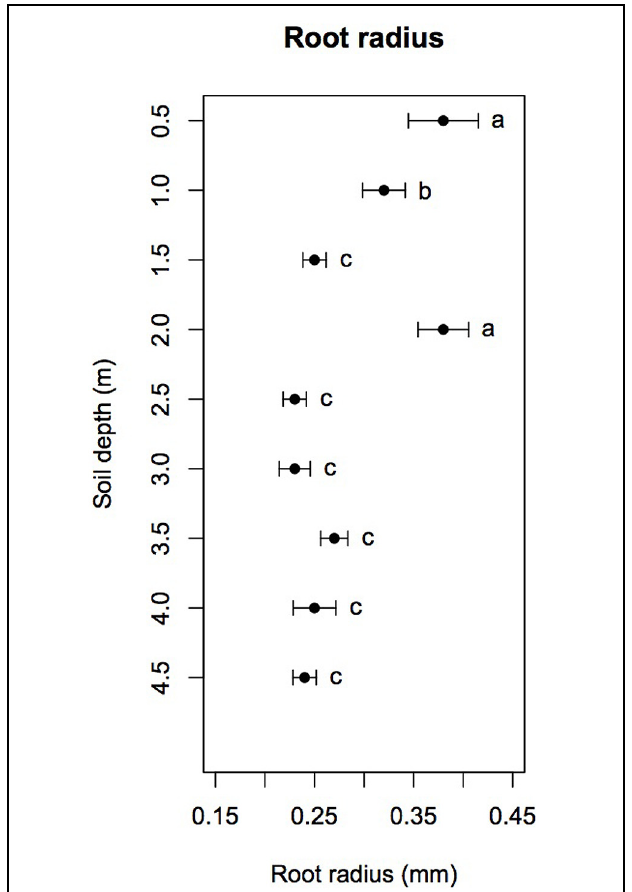
95% confidence intervals (error bars). Different letters indicate significant differences (Tukey HSD with α =